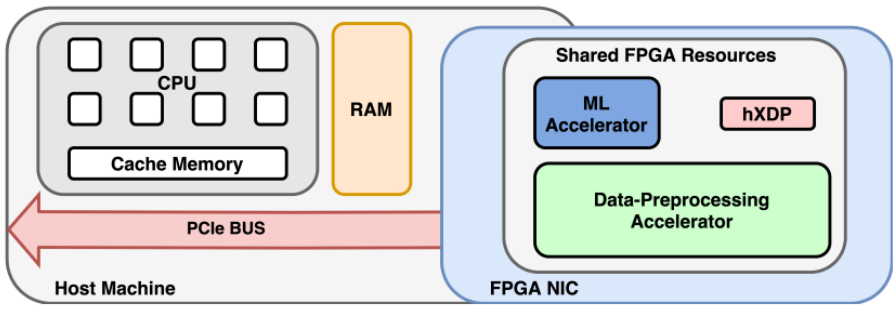
Figure 1. Specific accelerators of FPGA NIC resources and hXdp network accelerator.